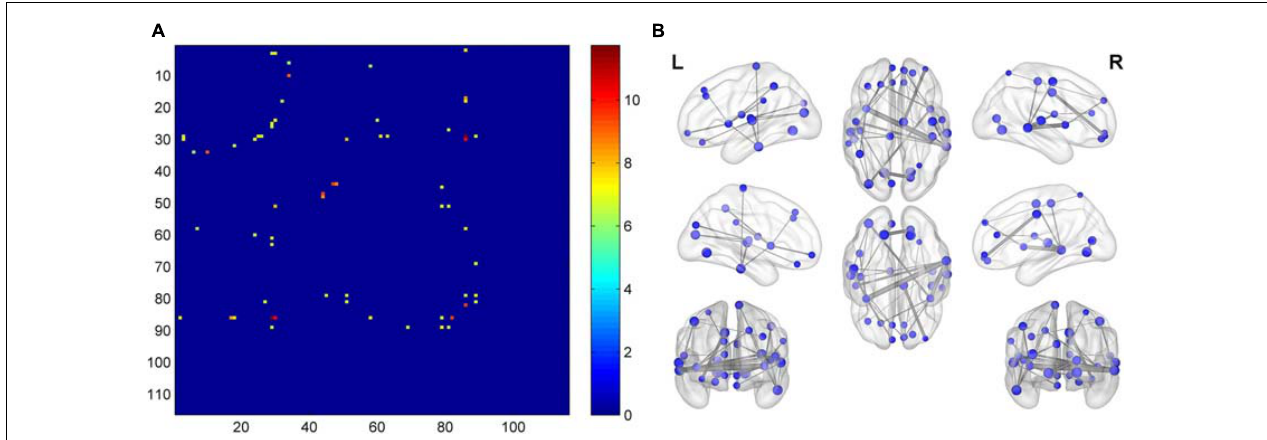
FIGURE 3 | Matrix plots and brain maps of significant F -values for differences in functional connectivity. (A) The dots represent F -values with differences, the darker the color, the more significant the difference. (B) On the brain map, the lines between brain regions represent differential F -values, and the thicker the line, the more significant the